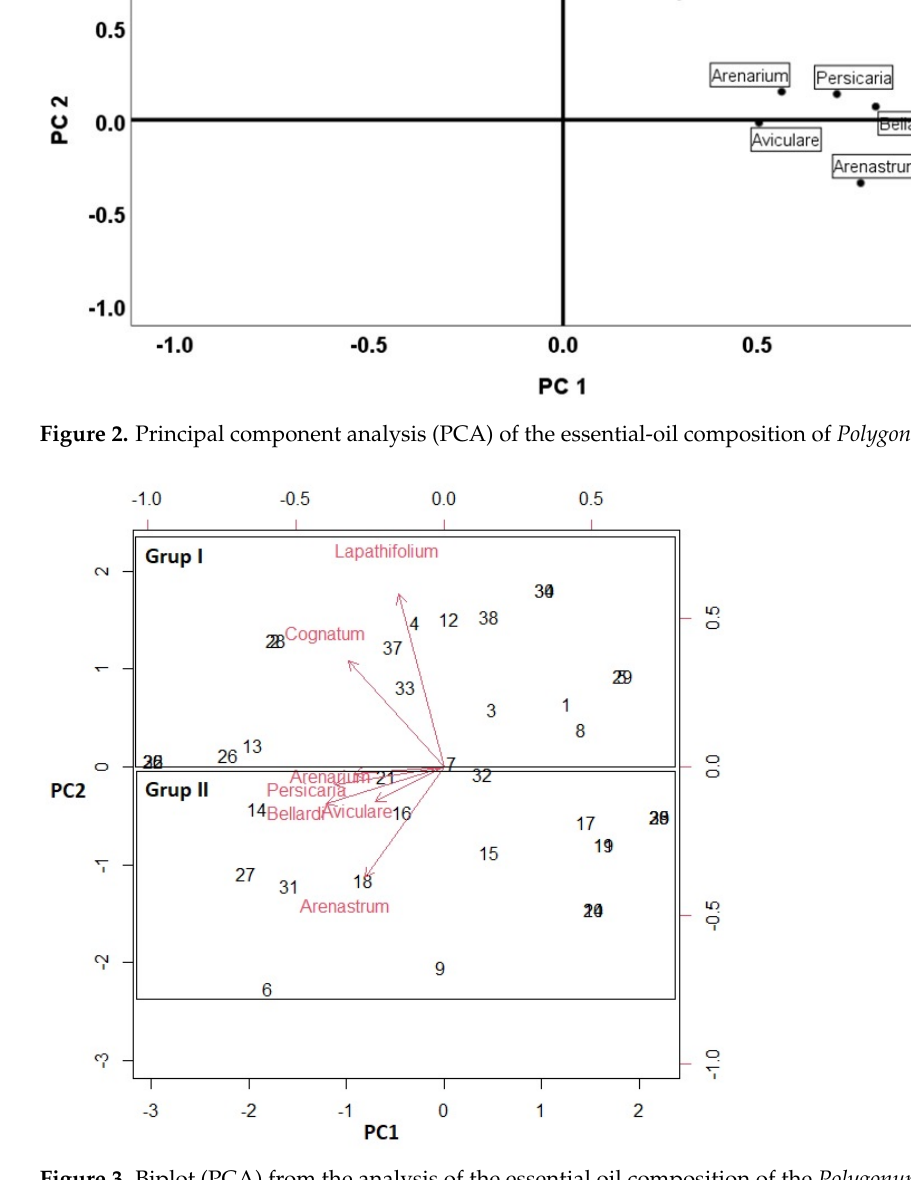
Figure 3. Biplot (PCA) from the analysis of the essential oil composition of the Polygonum species.